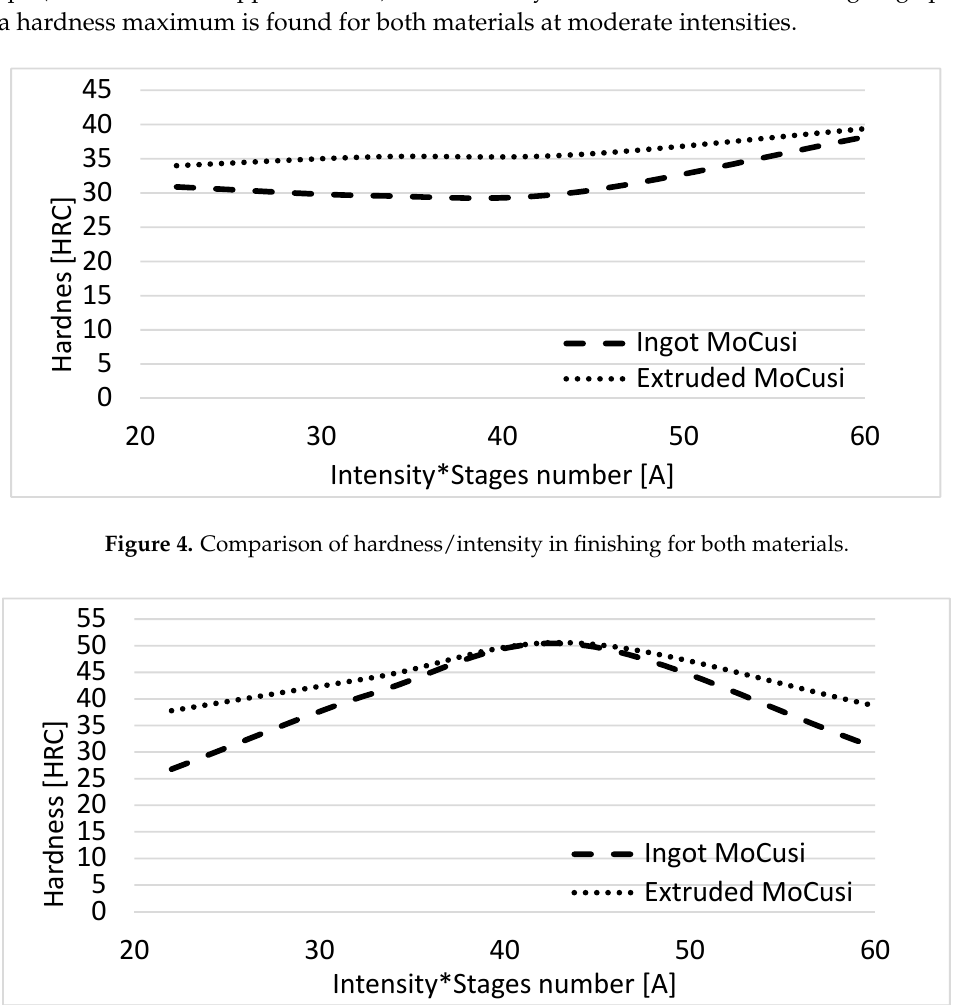
Figure 5. Comparison of hardness/intensity in roughing for both materials.